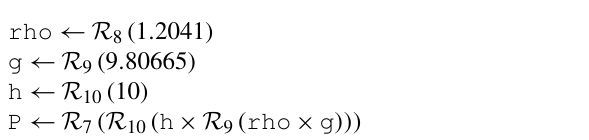
Algorithm 2 Operations performed by the mixed-precision program (Fig. 2).